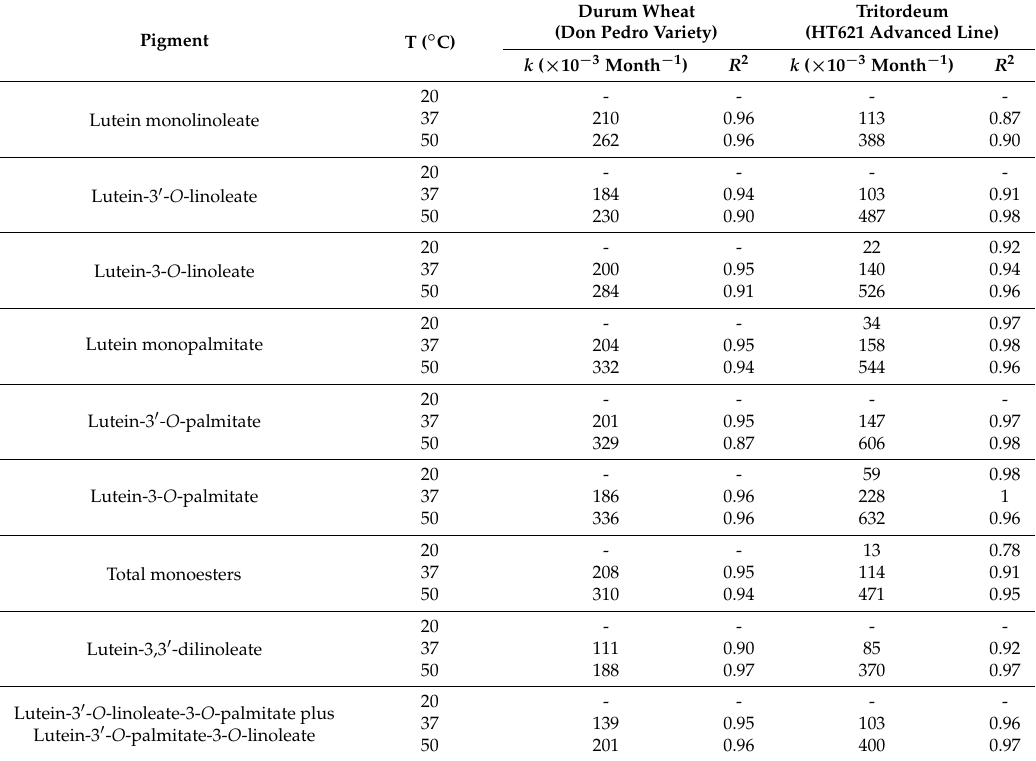
Table 5. Reaction rate constants ( k ; month − 1 ) for the esterified carotenoid content in durum wheat (Don Pedro variety) and tritordeum (HT621 line) whole-grain flours during a long-term storage period (12 months) at 20, 37, and 50 ◦ C following the first-order kinetic model (Ln( C / C 0 ) = − kt ).